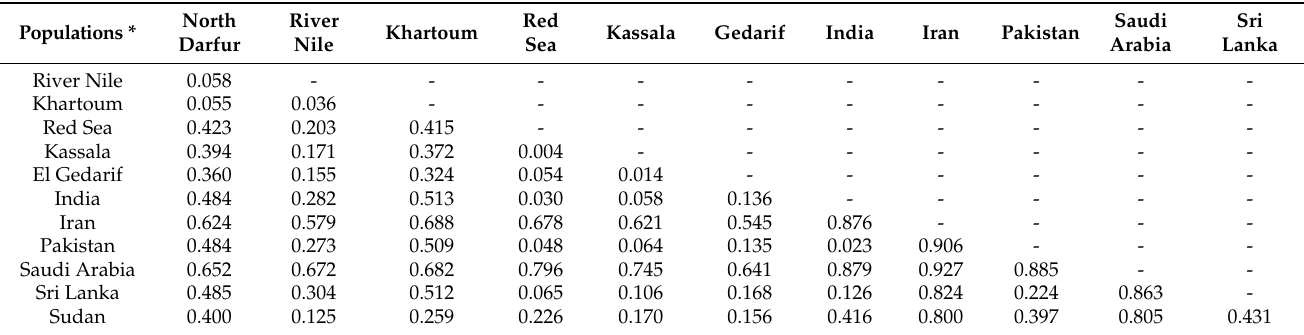
Table 3. Pairwise fixation index (Fst test values) between An. stephensi populations calculated from the nucleotide data set of CO1 gene.